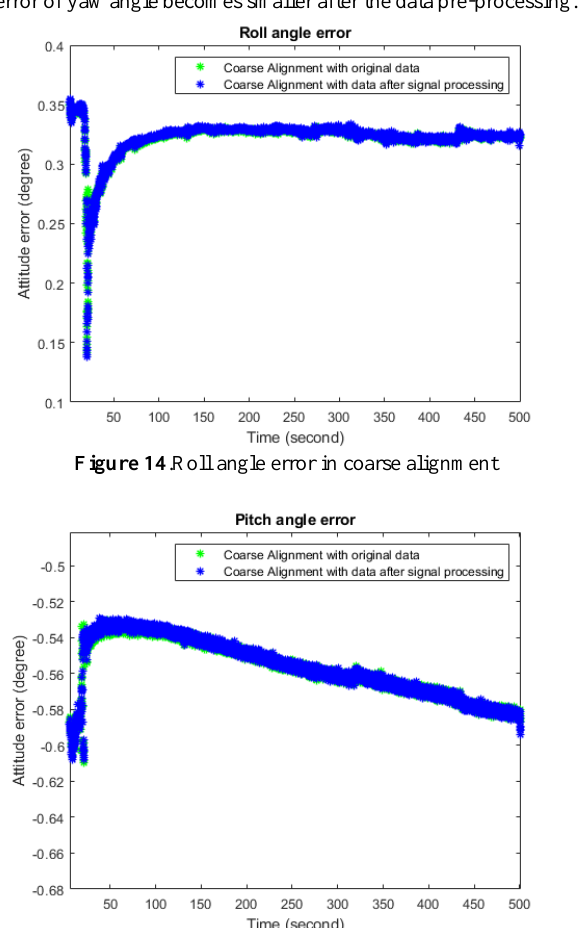
Figure 15 .Pitch angle error in coarse